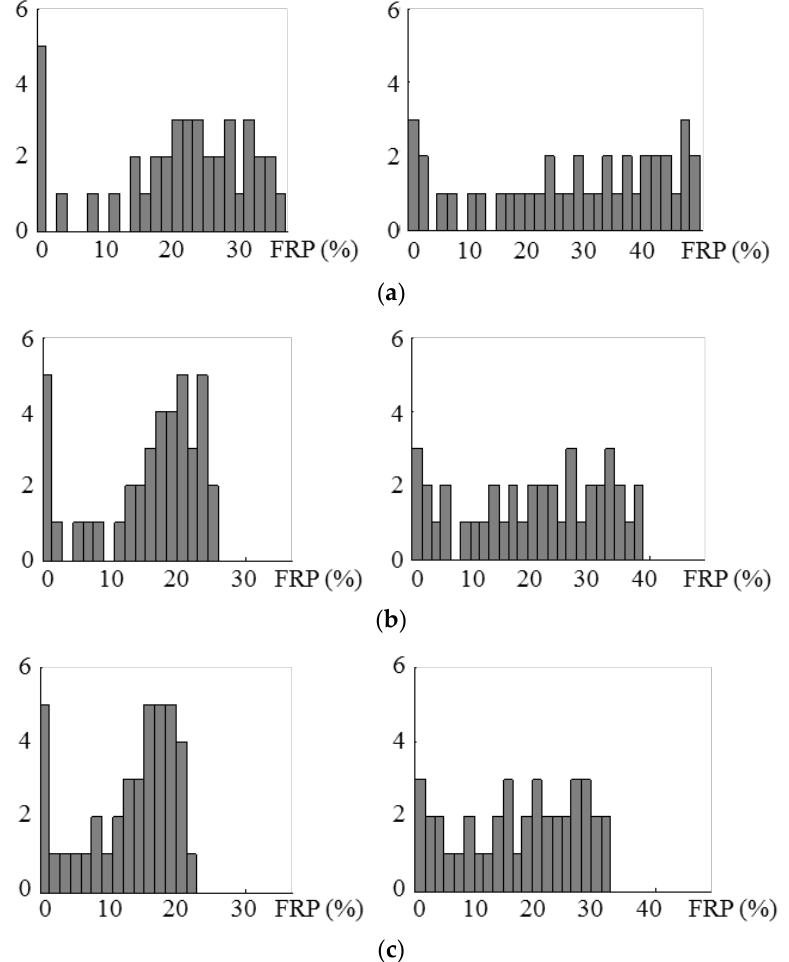
Figure 3. False rejection probability (FRP) histograms for speech in white noise ( left ) and babble noise ( right ) at 5 dB SNR at different 𝑀 : ( a ) 𝑀 = 100% , ( b ) 𝑀 = 50% , and ( c ) 𝑀 = 25% .